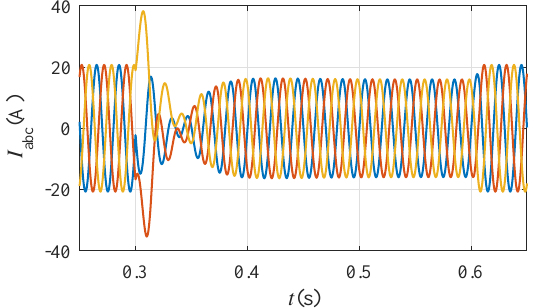
Figure 12. Variation of current under VSG control